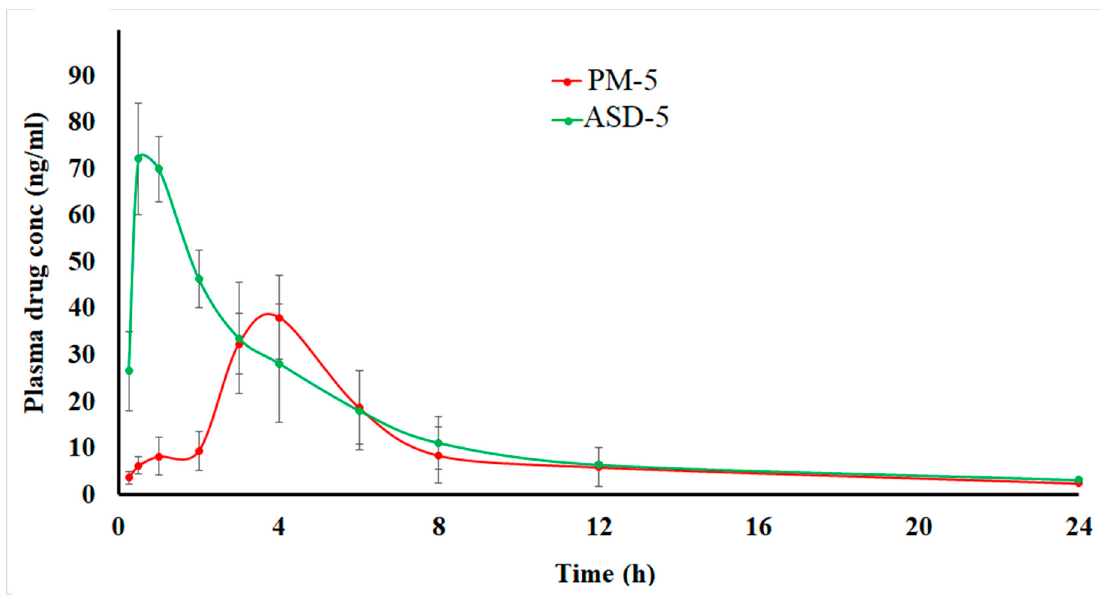
Figure 8. Pharmacokinetic profiles of the PM-5 and ASD-5 compressed tablets in rabbits.